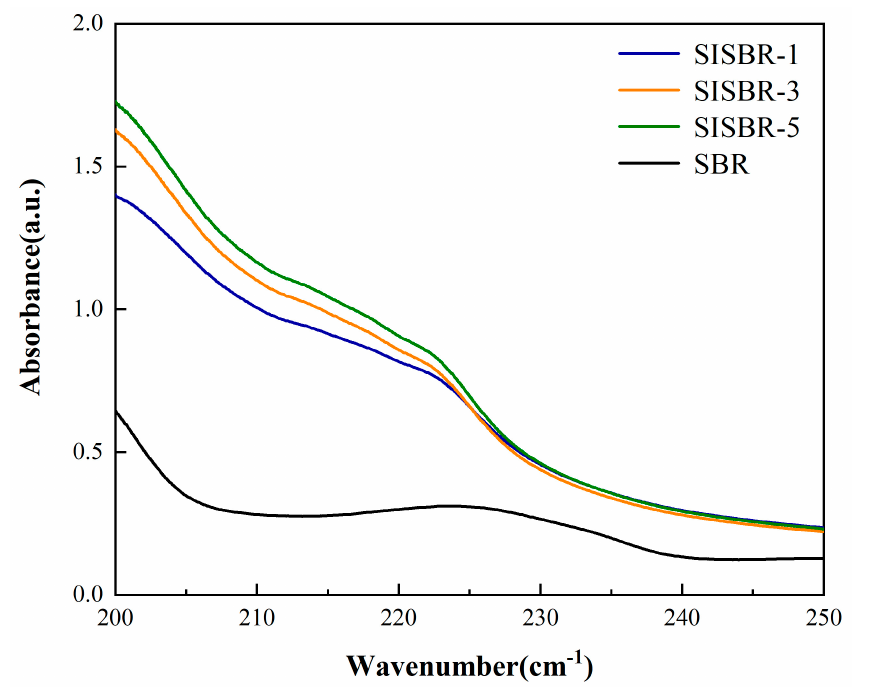
Figure 4. The correlation between the absorbance of latex and IA amount.